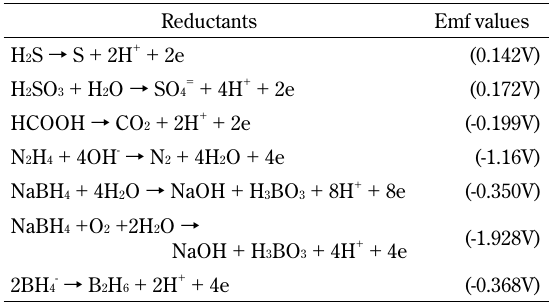
Table 2 Common reductants with their emf values 19,20 ） Reductants Emf